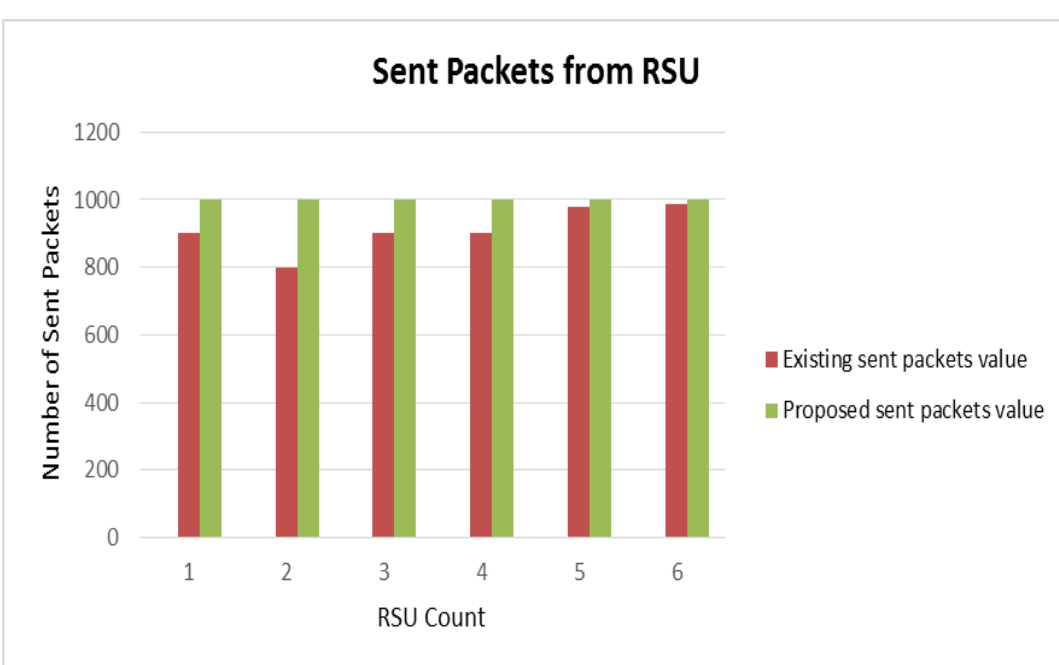
Figure 13. Sent Packets from